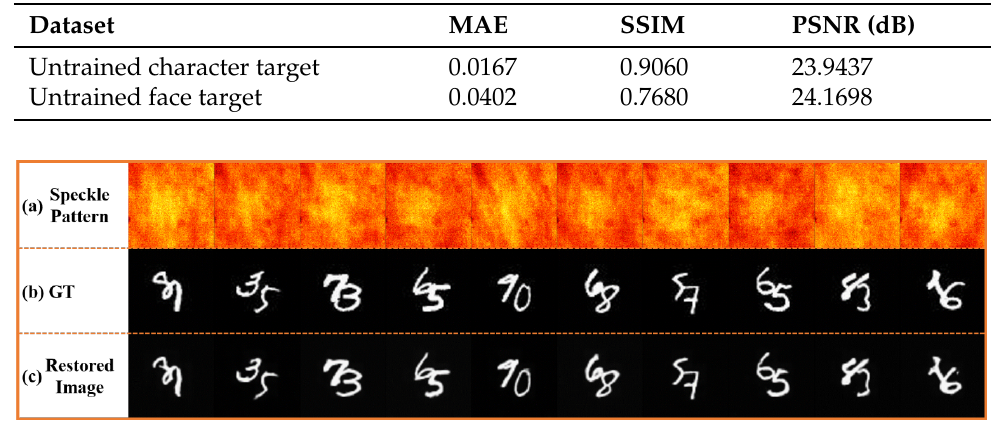
Figure 4. Dual-character experiment results. ( a ) The speckle pattern. ( b ) The Ground Truth (GT) of the hidden target. ( c ) The reconstruction results by using adaptive coding.